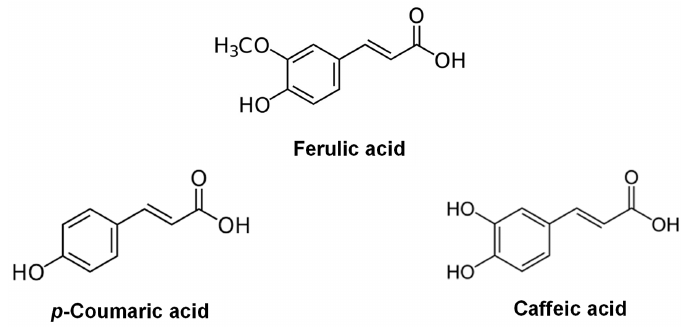
Figure 3. Antioxidant activity (AA) of BSG extracts against total phenolic compounds concentration (c) in water–organic solvent systems.